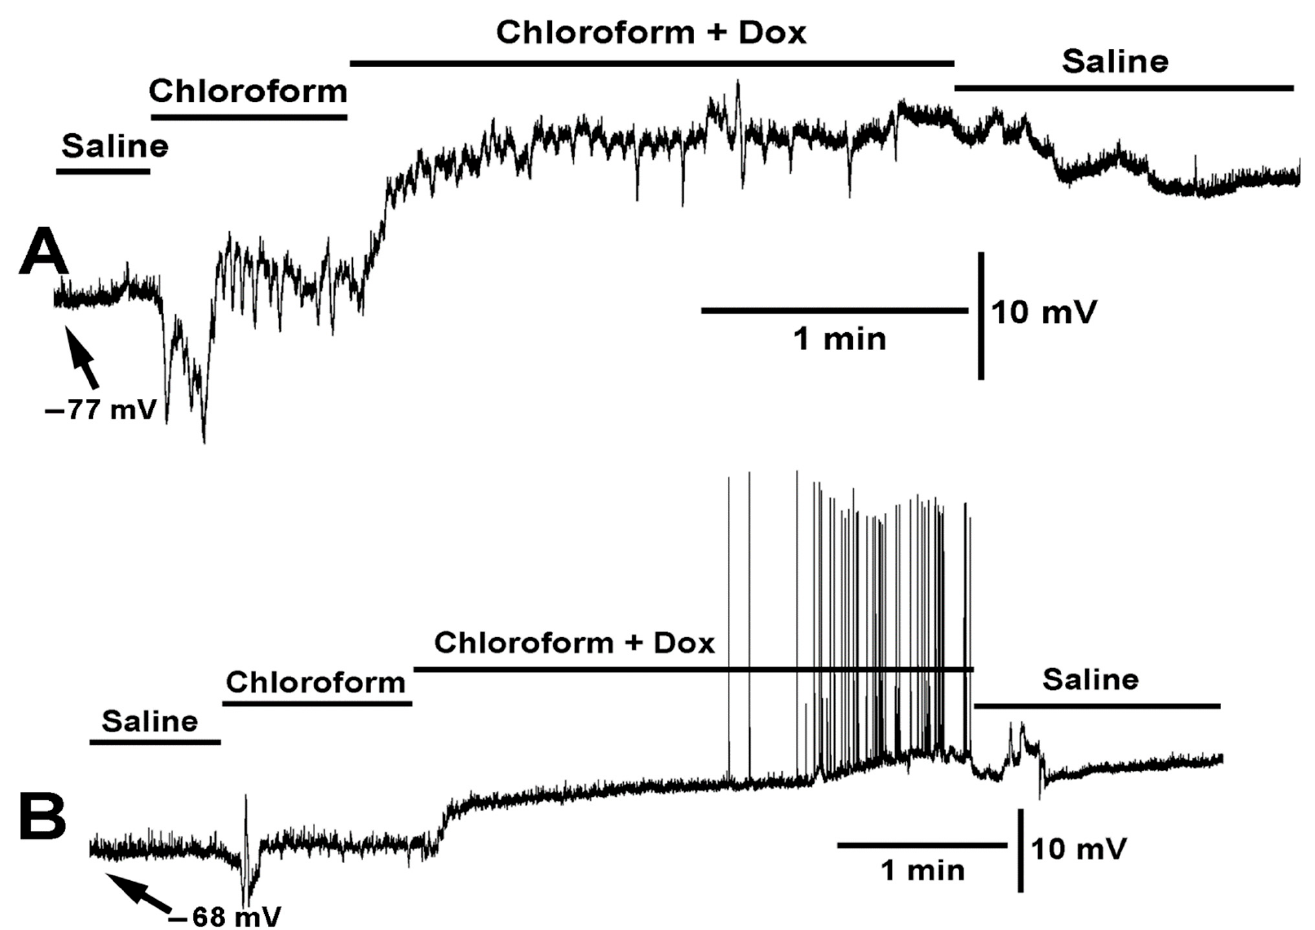
Figure 5. Two examples of the effect on membrane potential by chloroform (0.2%) and chloroform (0.2%) combined with doxapram (10 mM) are shown ( A , B ). Two different preparations are shown with the same mixtures of compounds. Upon exposure to chloroform the membrane rapidly hyperpolarized followed by depolarization. In ( A ), chloroform produced a series of contractions. With the exposure to chloroform and doxapram the membrane depolarized even more. In ( B ), doxapram induced EJPs, while in A the effect of chloroform continues to produce waves of contraction.